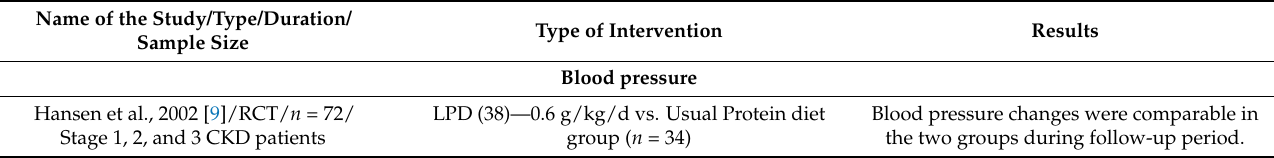
Table 1. Studies of protein restriction alone in chronic kidney disease (CKD) patients. Name of the Study/Type/Duration/ Type of Intervention Sample Size